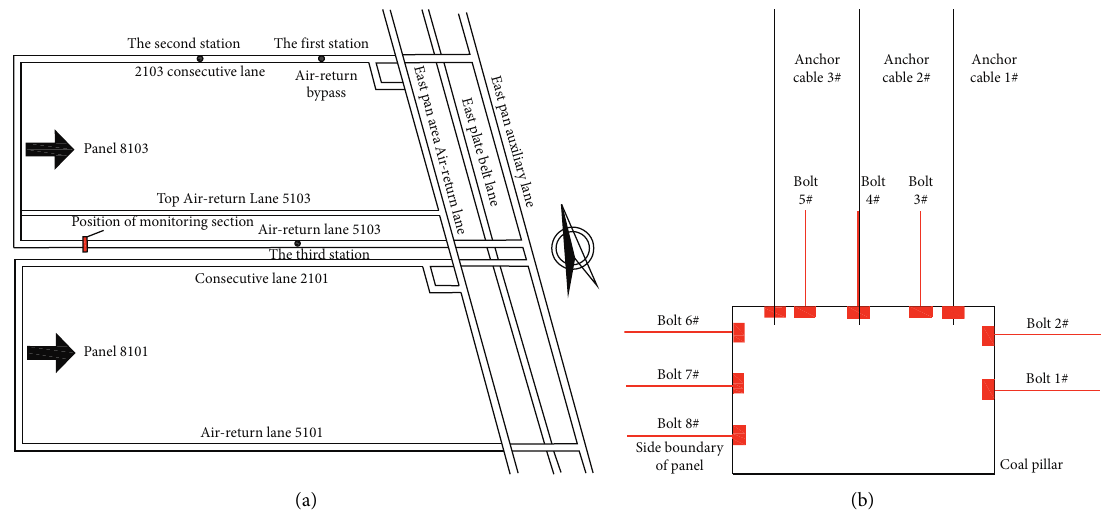
Figure 10: Layout of ground pressure monitoring points in air-return roadway 5103. (a) Layout of measuring points. (b) Arrangement of anchor cables dynamometer.